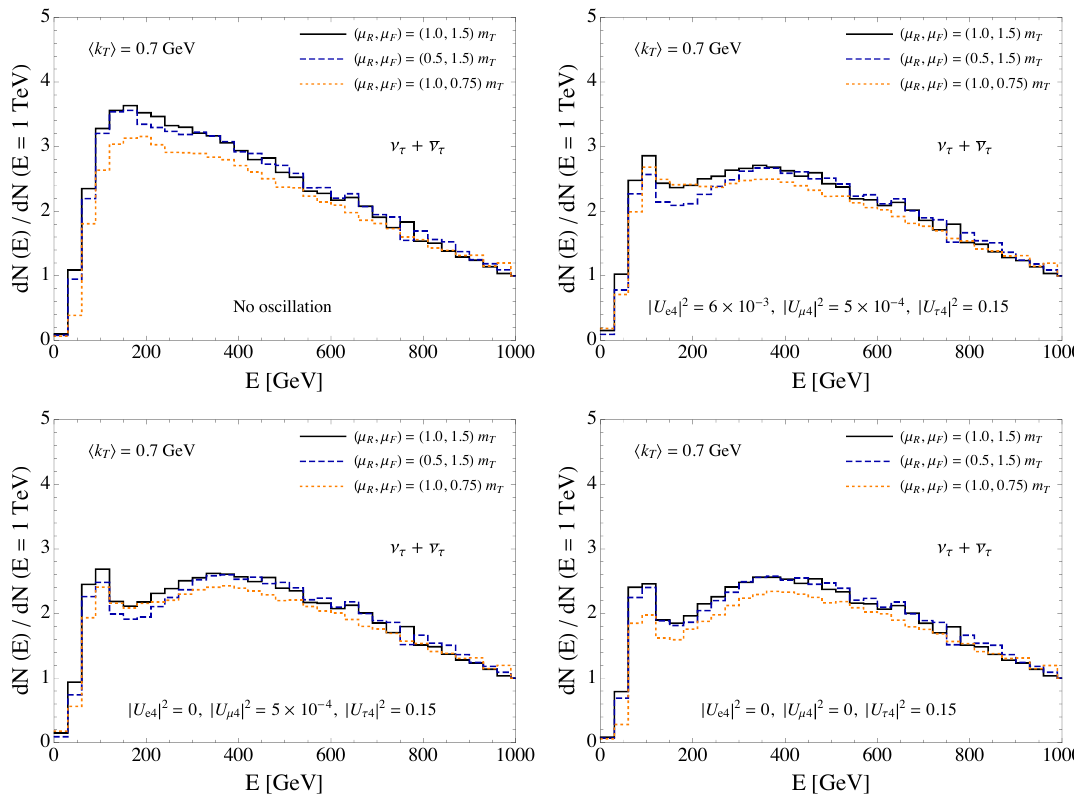
Figure 14 . The ratio of the number of (cid:23) (cid:28) + (cid:23) (cid:28) charged-current interaction events and the number of events at 1 TeV in each case, as a function of neutrino energy, without oscillations (upper left plot) and in a 3+1 oscillation scenarios with di(cid:11)erent mixing parameters. The numbers of events are evaluated for h k T i = 0.7 GeV for three di(cid:11)erent ( (cid:22) R , (cid:22) F ) scale choices that bracket the scale